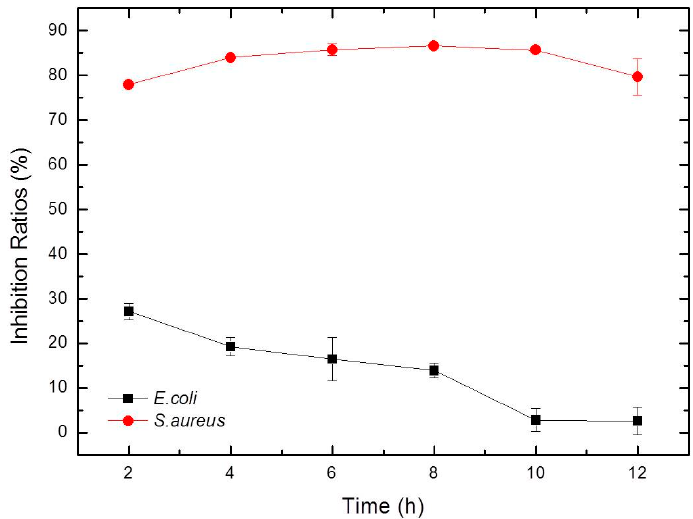
Figure 8. Inhibition ratio kinetic curves of SF/Gly/GA/Cur composite film against S. aureus and E. coli .